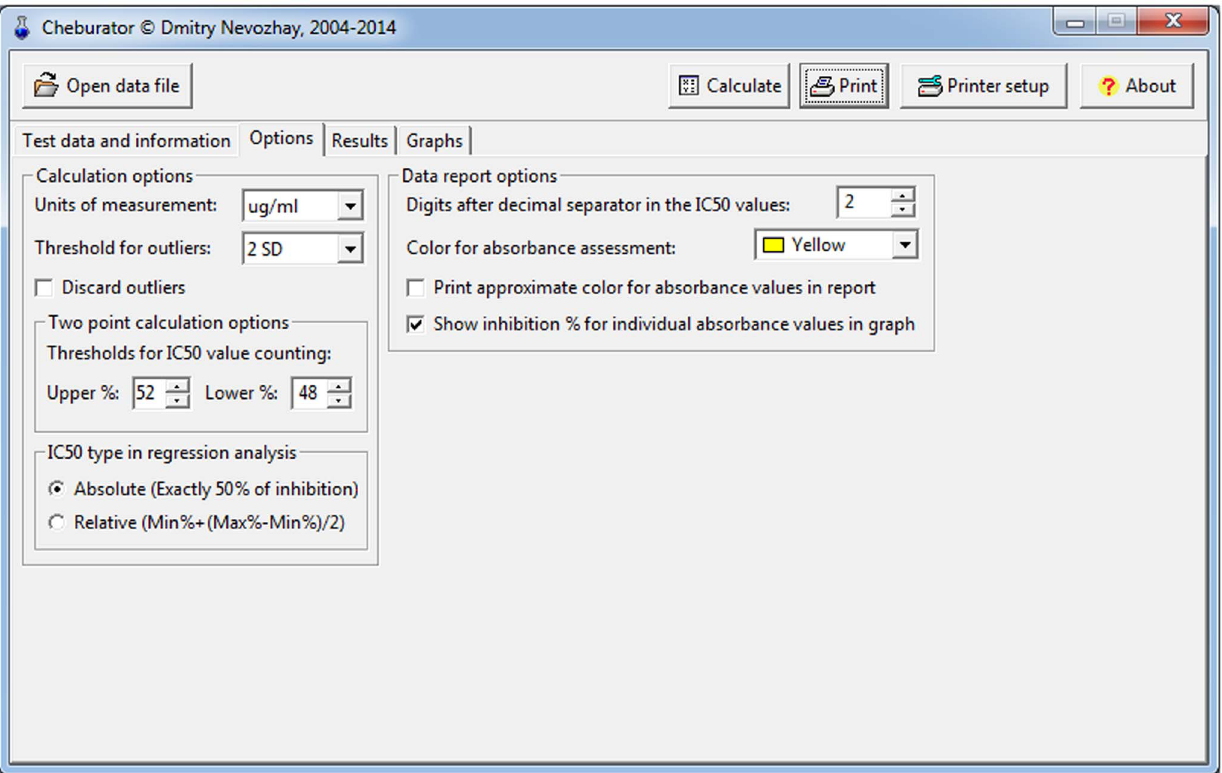
Figure 10. The Options tab. This tab allows user to customize different analysis and report parameters of the software.